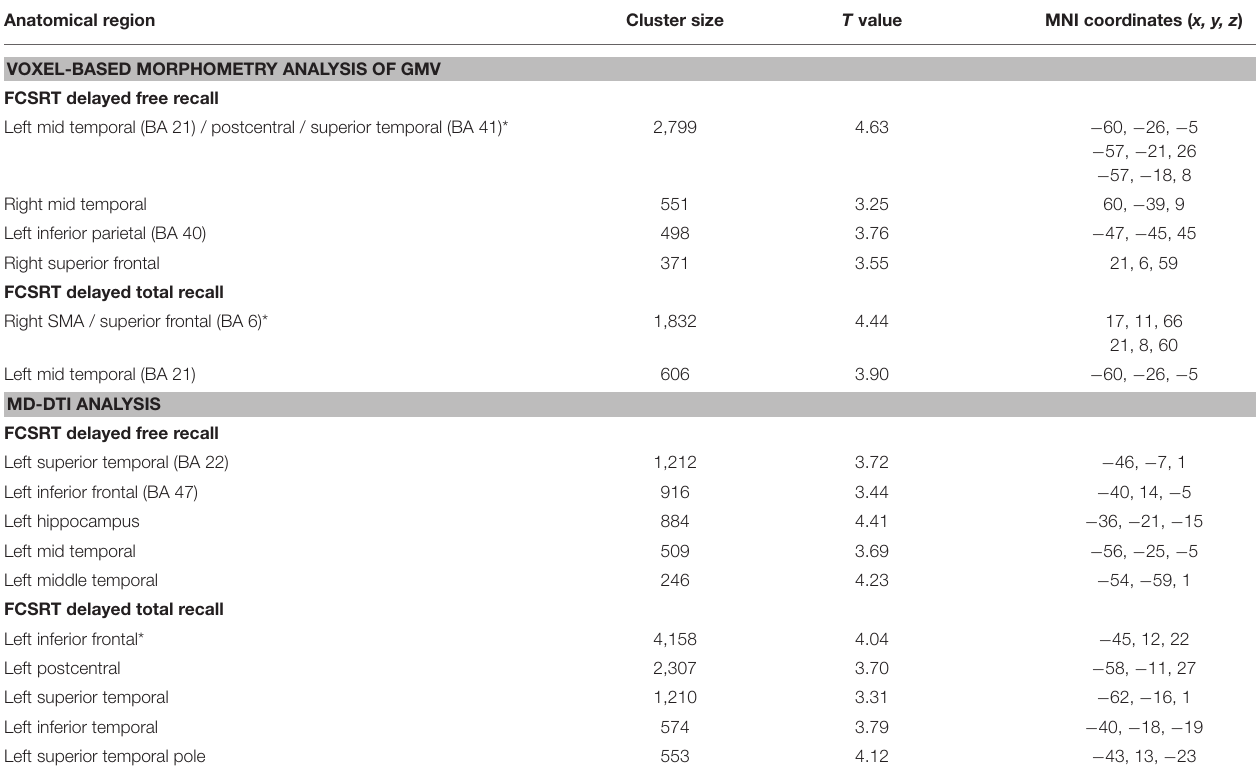
TABLE 4 | Results of the GMV voxel-based morphometry and MD-DTI analysis. Anatomical region Cluster size T value MNI coordinates ( x, y, z ) VOXEL-BASED MORPHOMETRY ANALYSIS OF